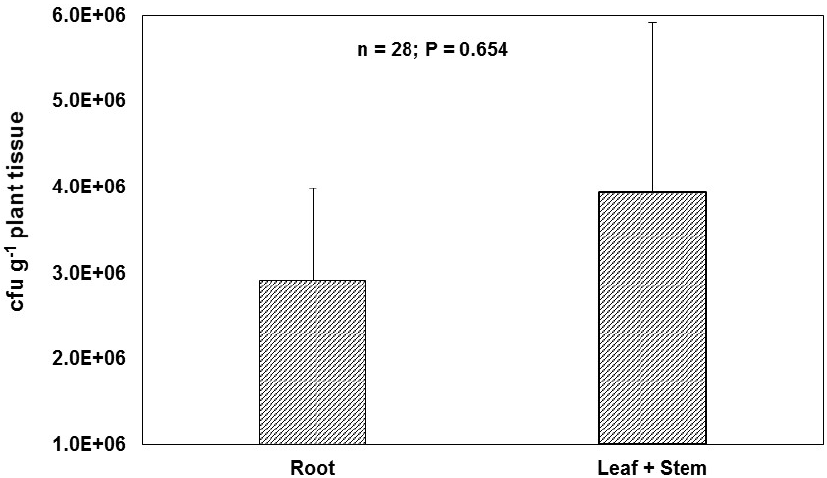
Figure 6. Quantification of CFUs of WP5 gfp per gram of tissue in shoots, including leaves and stem, and roots. Errors bars represent standard error of the mean.